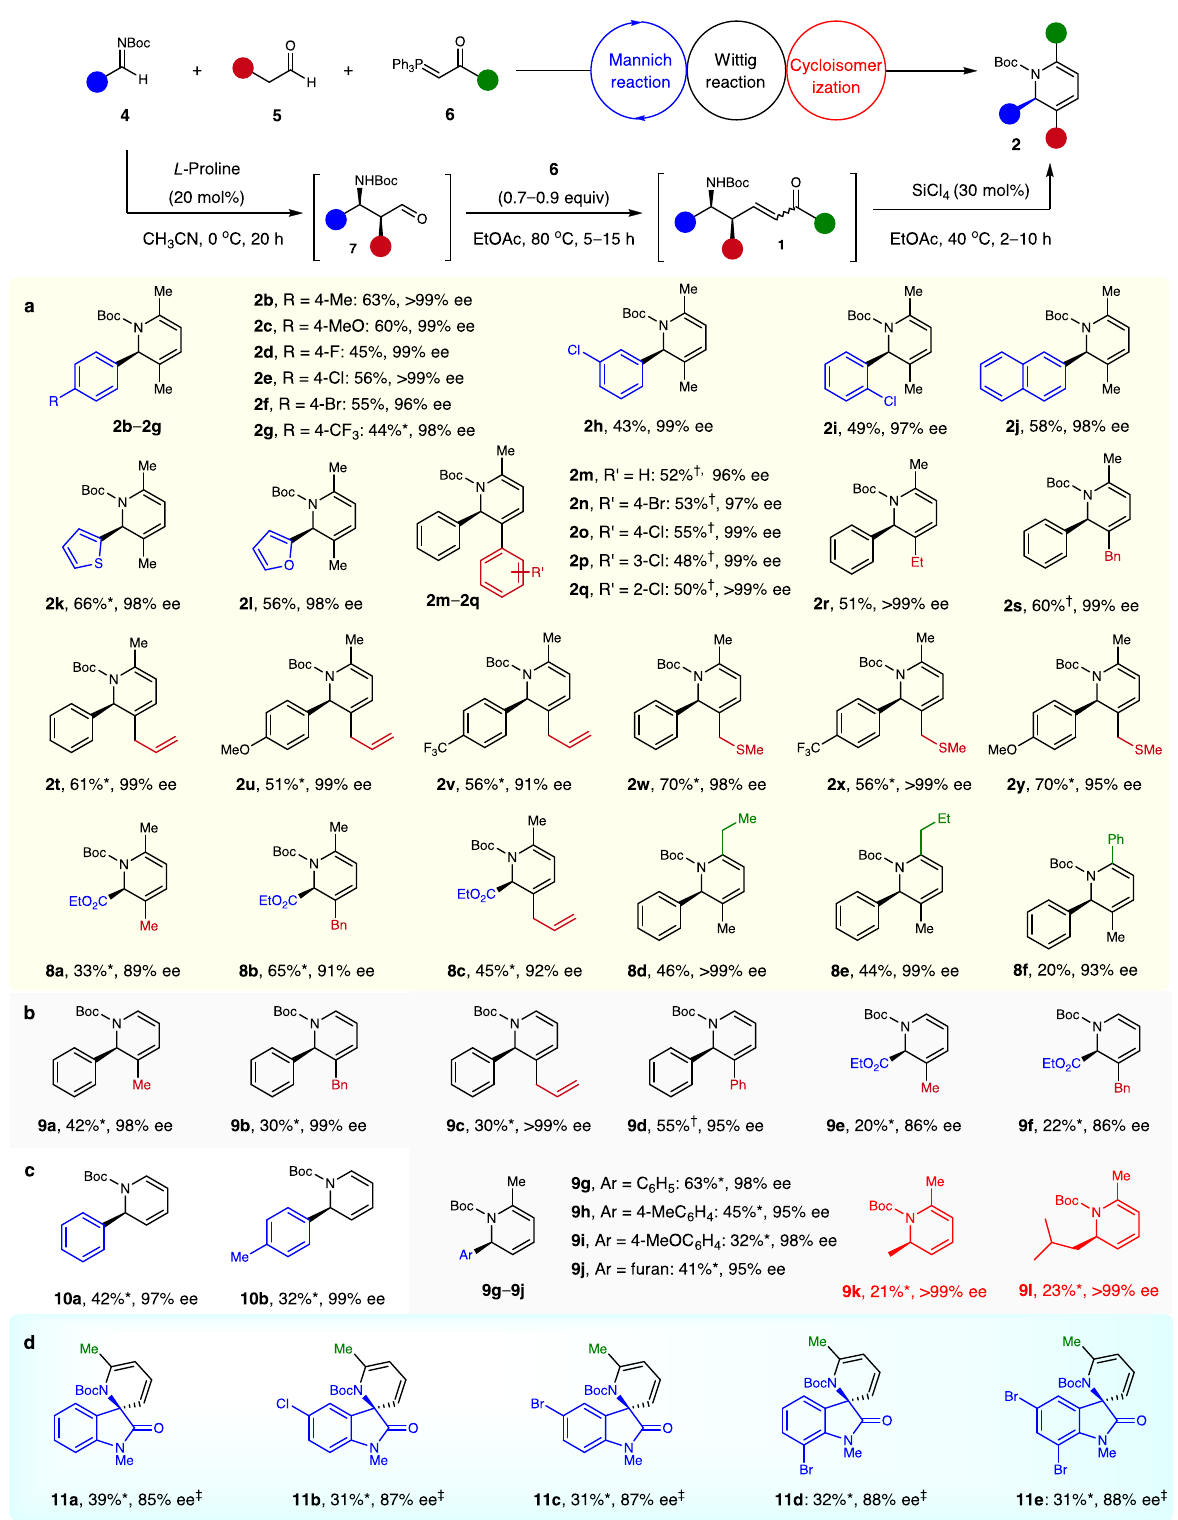
Fig. 3 Scope of asymmetric Mannich/Wittig/cycloisomerization sequence. Reaction conditions. Mannich step: imines 4 (0.5 mmol), aldehydes 5 (1.0 mmol), L -proline (20 mol%), CH 3 CN (10 mL), 0 °C, 20 h. Wittig step: ylides 6 (1.0 equiv based on the crude 7 ), EtOAc (2 mL), 80 °C, 15 h. Cycloisomerization step: SiCl 4 (30 mol%), EtOAc (2 mL), 40 °C, 2 – 10 h. Unless otherwise noted, overall yields for 3 steps are given. Ee values were determined by chiral HPLC analysis. *These reactions begin from the corresponding isolated chiral β -amino aldehydes 7 and the yields for two steps are given. † Using 1.0 equiv of 5 . ‡ Using SiCl 4 (45 mol%) instead of SiCl 4 (30 mol%). For details, see the Supplementary Information. a Synthesis of 2,3,6- trisubstituted 1,2-dihydropyridines. b Synthesis of 2,3- and 2,6-disubstituted 1,2-dihydropyridines. c Synthesis of 2-substituted 1,2-dihydropyridines. d Typical examples with isatin-derived N -Boc ketimines.